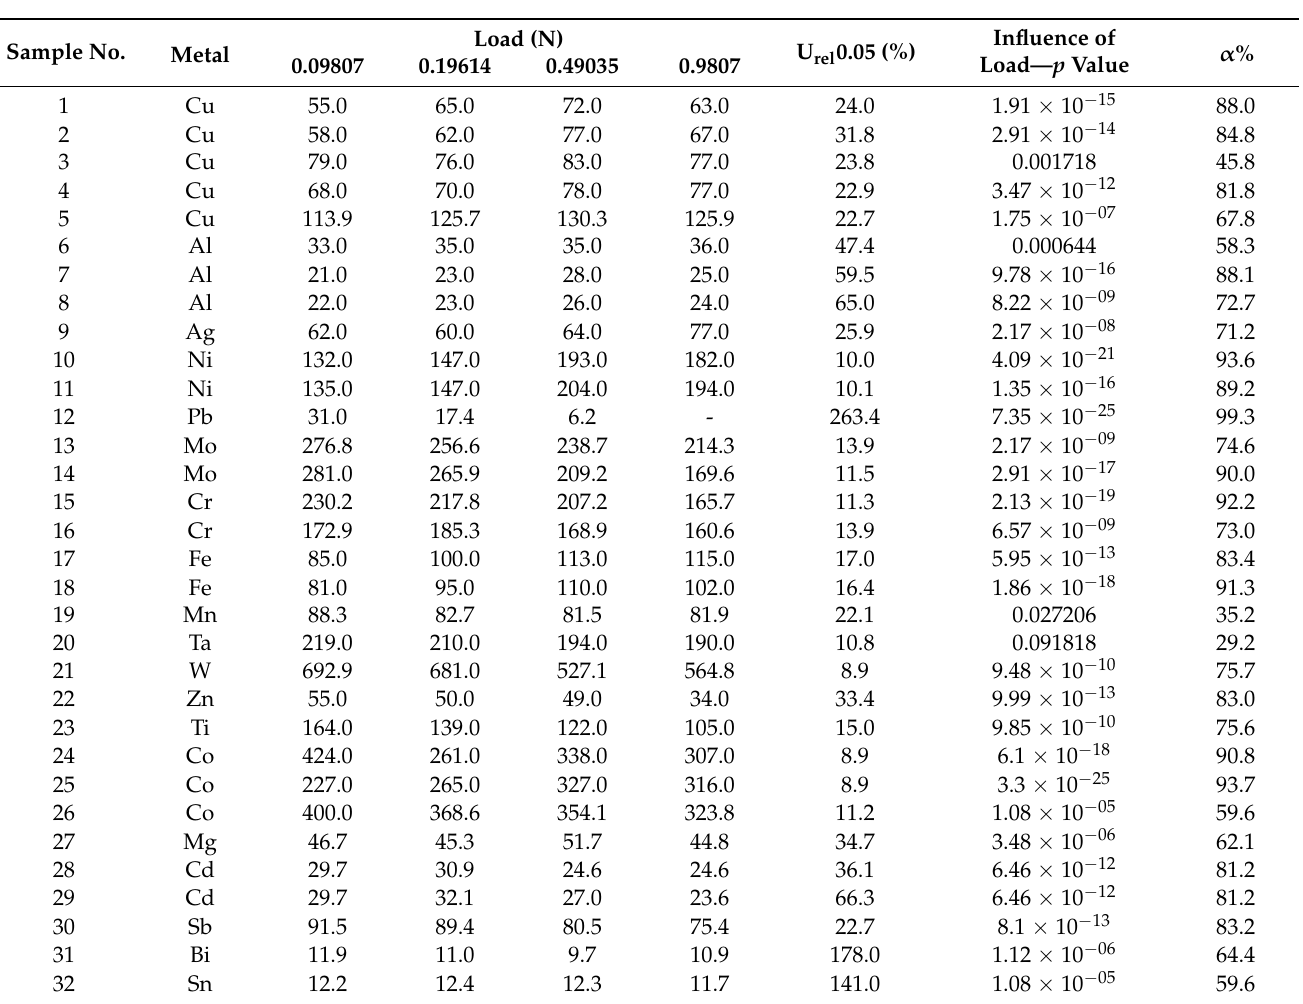
Table 3. The micro-hardness at selected loads, relative expanded uncertainty U rel at HV0.05, and the influence of the load on the micro-hardness expressed by p - α